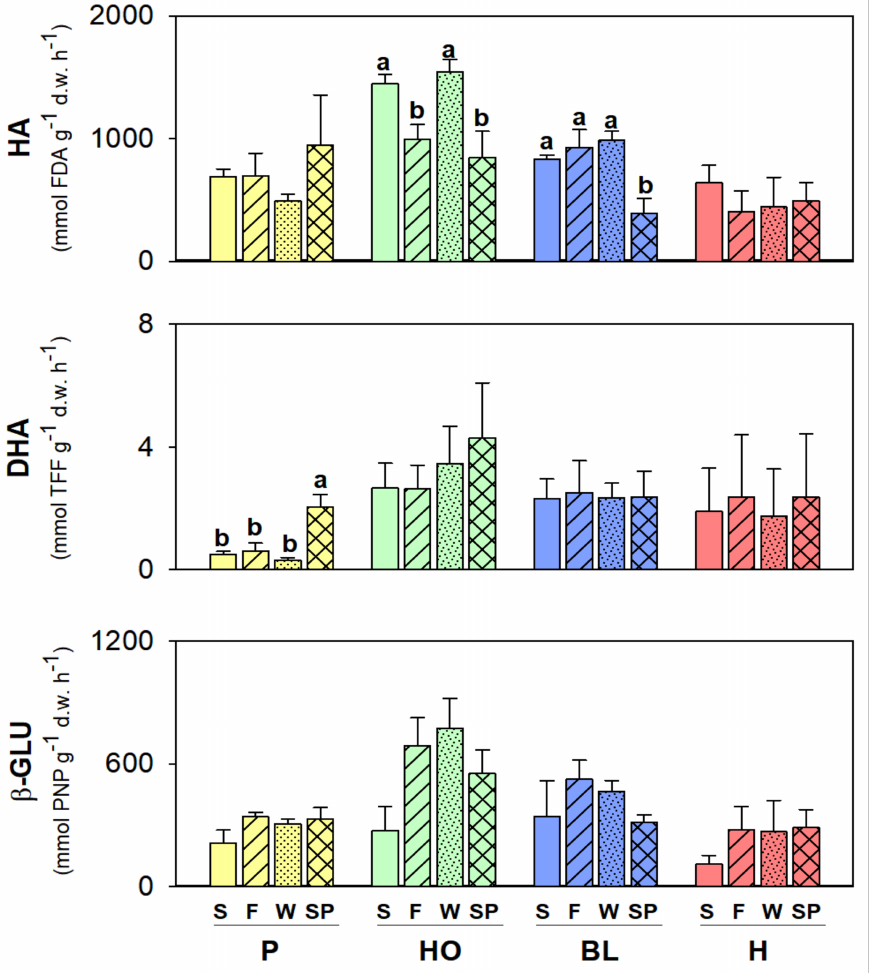
Figure 1. Mean values ( n = 6, ± s.e.) of the enzymatic activities (hydrolase: HA; dehydrogenase: DHA; β -glucosidase: β -GLU) measured in surface (0–10 cm) soils collected inside the Vesuvius National Park (Southern Italy) under different vegetation covers (P: pine; HO: holm oak; BL: black locust; H: herbs) in summer (S) and fall (F) 2018, and winter (W) and spring (Sp) 2019. Different letters indicate statistically significant differences in enzymatic activities among different seasons under the same vegetation cover ( t -test, at least, p <